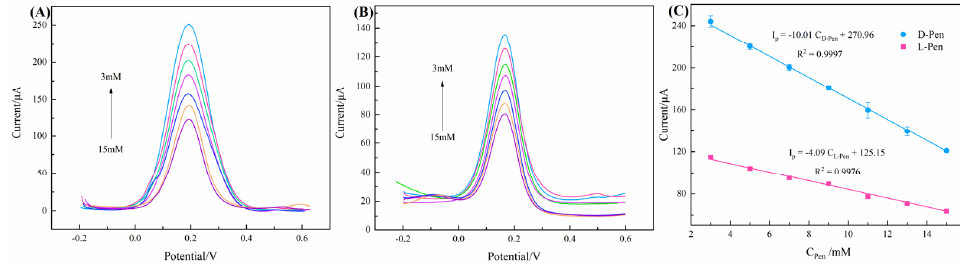
Figure 10. DPV of D-Pen ( A ) and L-Pen ( B ) at various concentrations; ( C ) The linear association of the peak current values to concentrations of D-Pen and L-Pen in 0.1 M KCl containing 5 mM [Fe(CN) 6 ] 4 − /3 − . Table 2. A comparison of the developed electrochemical methods in the limit of detection. Chiral Material